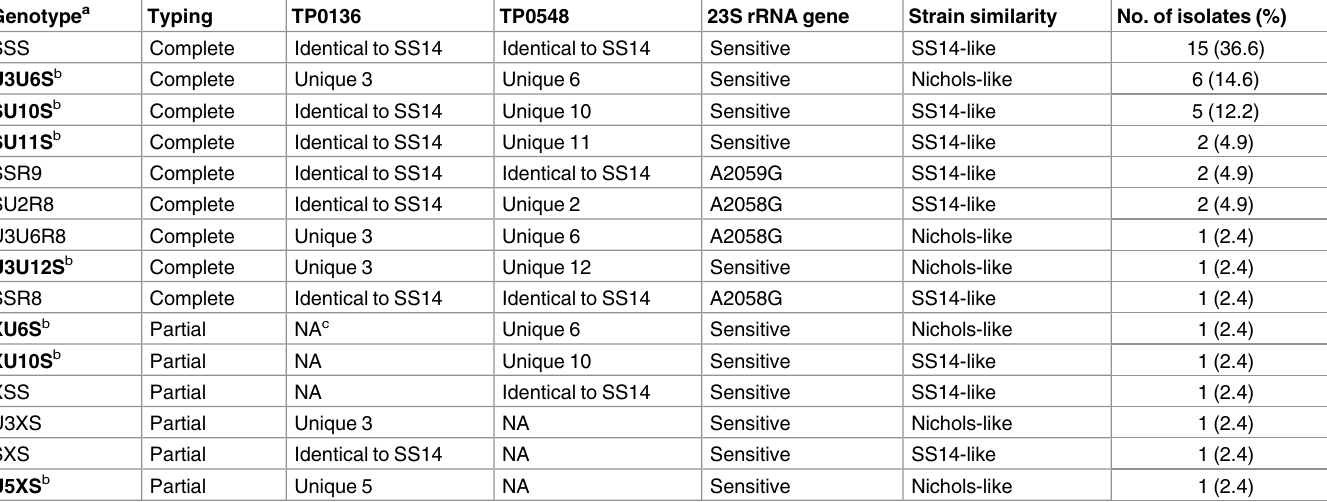
Table 2. Characteristics of detected genotypes using SBMT on 41 samples from syphilis PCR-positive patients from Buenos Aires, Argentina. Genotype a